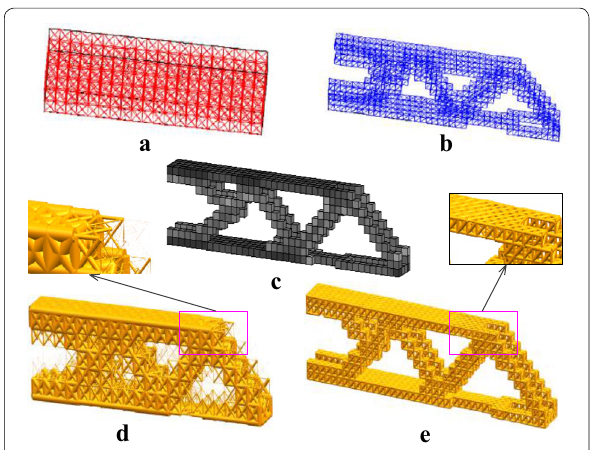
Figure 7 Generated 3D lattice structures using RDM and LRDM methods: a RDM 3D mesh; b LRDM 3D mesh; c Topology optimization result; d RDM 3D lattice structures; e LRDM 3D lattice structures